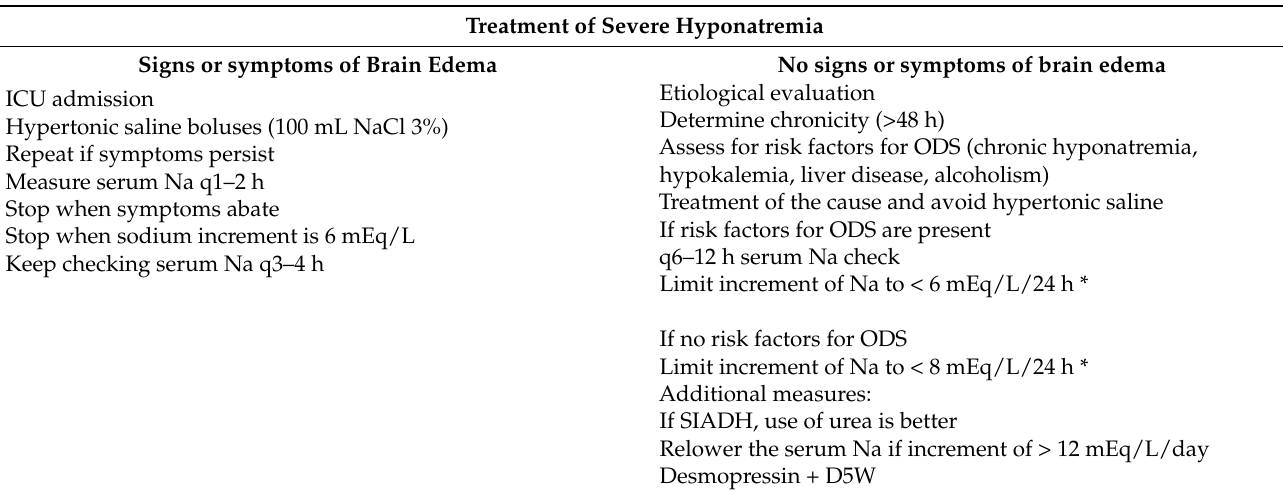
Table 2. Proposed approach for the treatment of severe